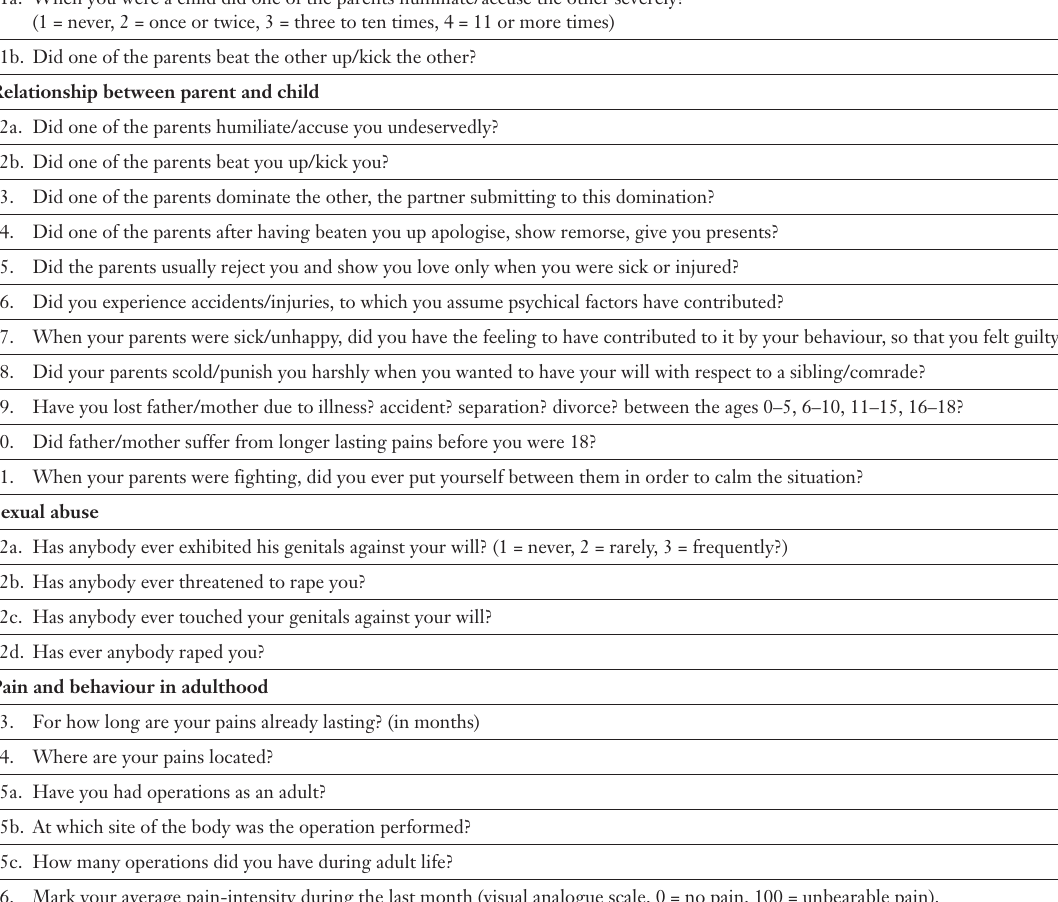
Traumatic Childhood Experiences